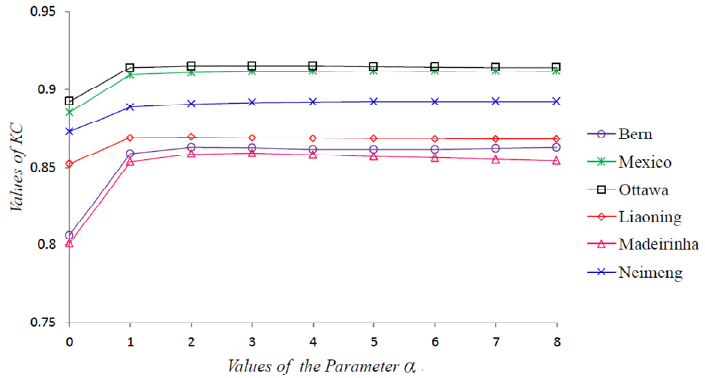
Figure 6. Testing curves of parameter α on six remote sensing datasets.